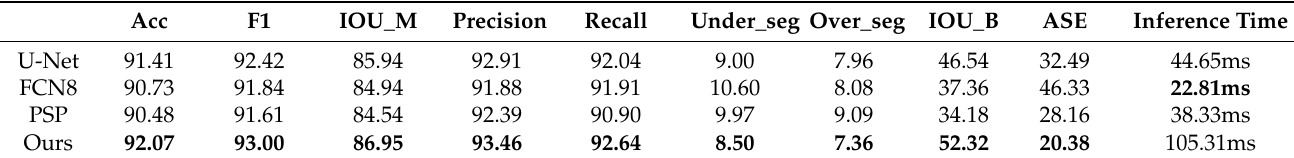
Table 7. Comparison among different models. The bold number means the best